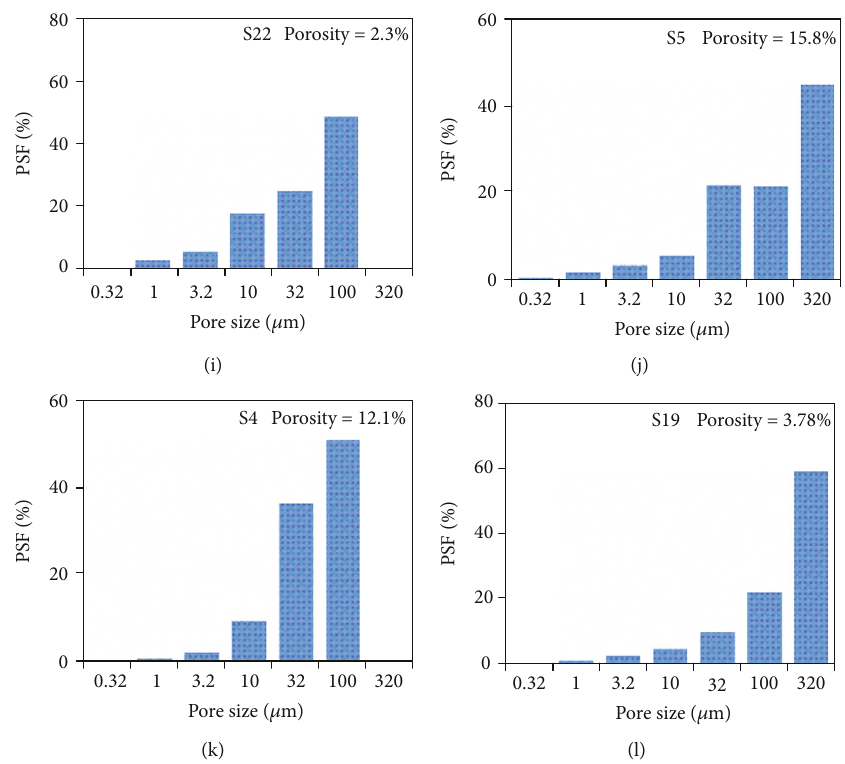
Figure 3: Thin section images, binary images, and pore size distribution of dolostone samples. (a) Intercrystalline pores and intercrystal x, medium crystalline dolomite. (b) Intercrystal dissolved pores in sample S32, well dissolved pores in sample S2, well BT5, 5782.08m, ∈ 1 MB1, 6002.98m, ∈ s, silty crystalline dolomite. (c) Fracture and intercrystal dissolved pores in sample S22, well YQ6, 7061.07m, ∈ 2 coarse crystalline dolomite. (d – f) The binary image of samples S2, S32, and S22, where the white and black pixel represents pore and solid matrix, respectively. (g – l) The pore size distribution and porosity of samples S2, S32, S22, S5, S4, and S19 corresponding to images in Figure 2 and this fi